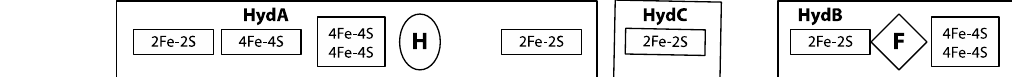
Figure 2. Domain organization of multimeric Fe-Fe hydrogenases. Large boxes represent hydrogenase subunits. The trimeric bifurcating/confurcating hydrogenase from T. maritima is shown for comparison. H, H-cluster; 2Fe-2S, cluster binding site; 4Fe-4S, cluster binding site; F, FMN and NAD + binding site. T. maritima data from Soboh and co-workers (2004) [61].